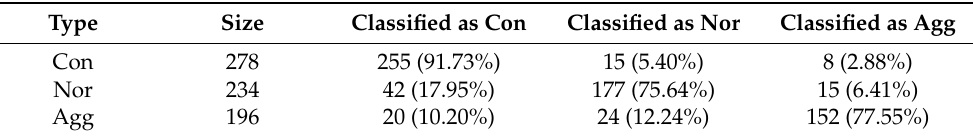
Table 2. Confusion matrix for validation dataset when velocity, geo-information, time, fgx, fgy, and fgz are